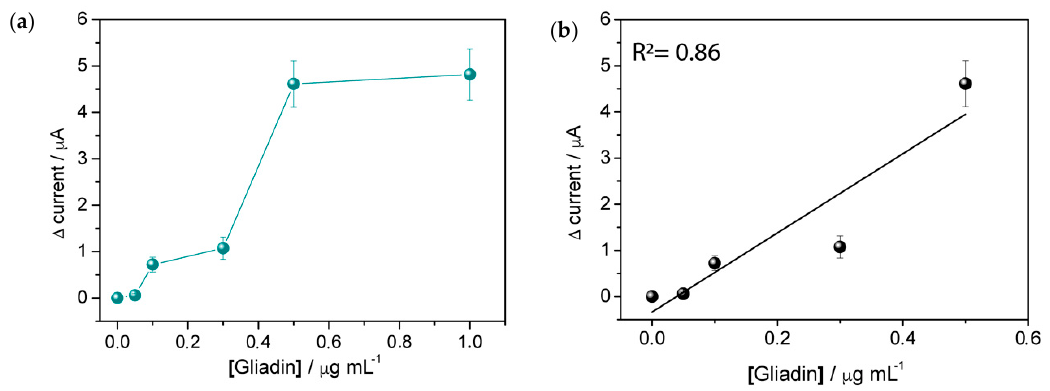
Figure 7. ( a ) ∆ current as function of gliadin fragment concentration and ( b ) linear response for gliadin concentration ≤ 0.5 µg mL − 1 . Signal obtained by cyclic voltammograms in 0.1 mM MB in the absence and presence of decreasing concentrations of gliadin (0.5–10 µg/mL). Scan rate, 50 mV s − 1 ; supporting electrolyte, 0.1 mM MB in 0.01 M PBS; and pH 7.2.